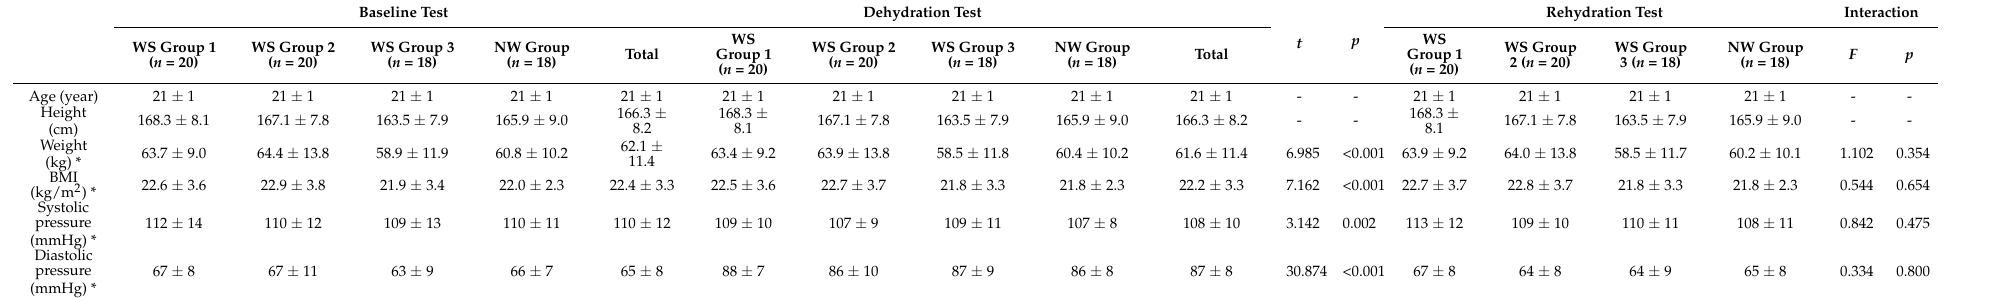
Table 1. The characteristics of the